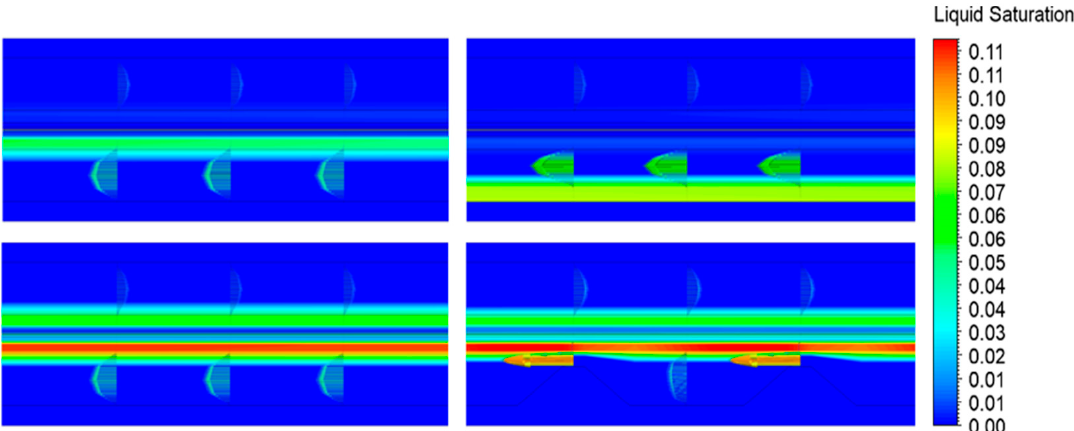
Figure 6. Liquid saturation contours: conventional rectangular channels ( above left ); biporous cathode channel ( above right ); porous cathode channel ( below left ); porous and baffled cathode channel ( below right ) at operating current density of 4.0 A·cm − 2 .